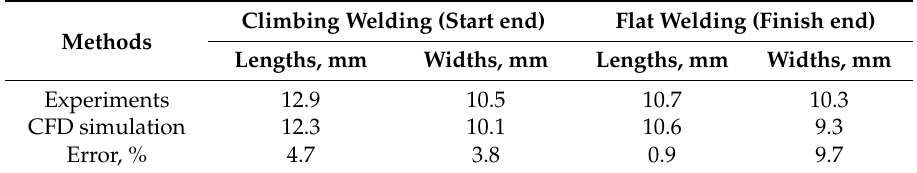
Table 5. Dimensions of weld pools obtained by CFD predictions and experimental measurements.